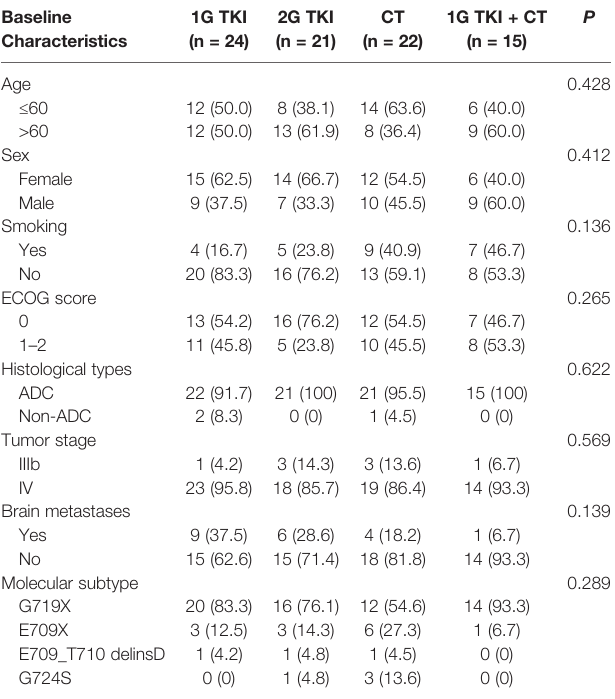
TABLE 1 | Baseline characteristics of patients. Baseline Characteristics